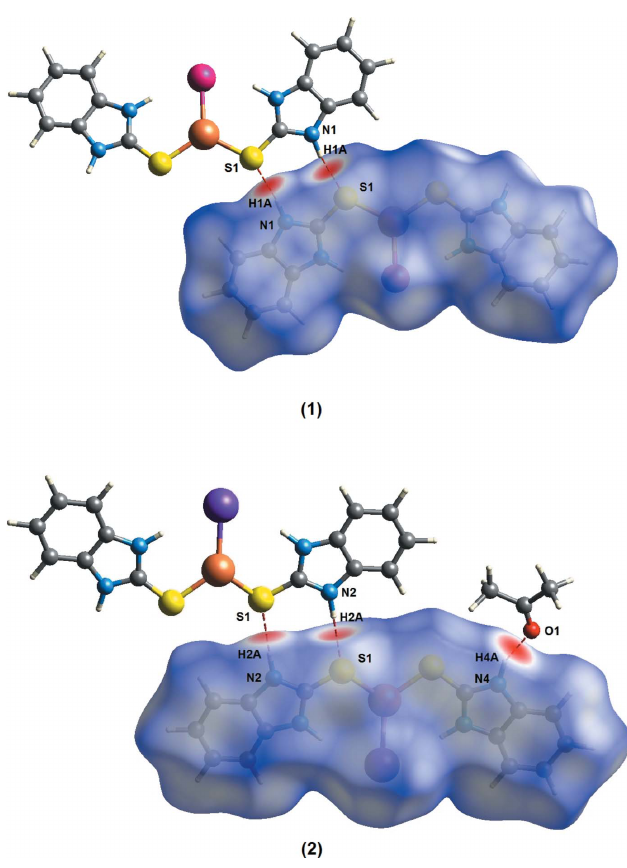
Figure 6 Hirshfeld surfaces plotted over d norm showing the areas of intermolecular hydrogen-bonding contacts of ( 1 ) and ( 2